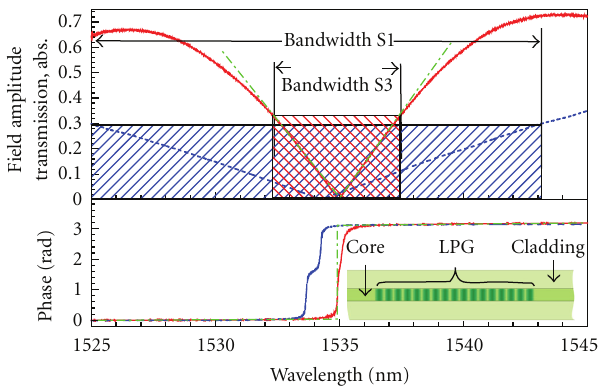
Figure 3: Amplitude and phase characteristics of the fiber LPG filters. Measured field amplitude and phase characteristics of the realized long, S3 (red) and short S1 (blue) LPGs together with the theoretical characteristics of an ideal di ff erentiator similar to S3 (green, dash-dotted lines). The S3 and S1 LPG operational band- widths (highlighted in the figure) are 5.5 nm and 19nm, respec- tively. The inset shows a fiber uniform LPG, where the level of green corresponds to the refractive